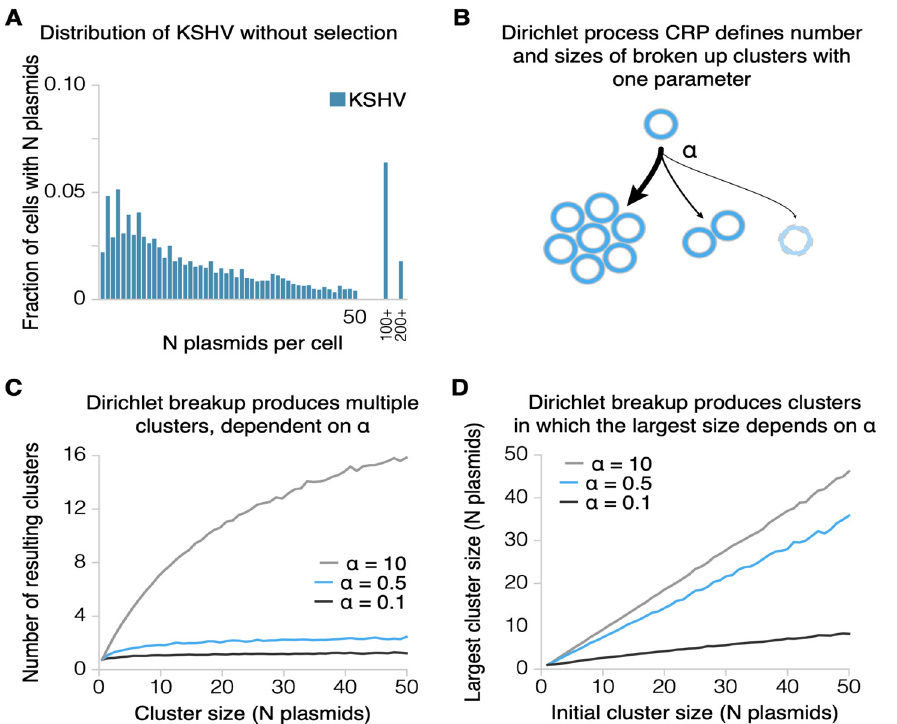
Figure 4. The distribution of KSHV plasmids per cell requires the addition of the modeling of clusters of plasmids and their associated breakup. ( A ) The distribution of KSHV plasmids per cell with no selection. Two bars at the right show the fraction of simulated cells with unrealistically high numbers of plasmids per cell. ( B ) The CRP is entered for each plasmid with a probability of 0.8 (as described in the findings of Chiu et al. [2]). This breaks up clusters, assigning each resulting cluster to the first resulting breakup cluster, and is passed then to successive clusters until a new cluster is formed. This process is represented here with the relative probabilities of forming each size of cluster. ( C ) The CRP produces multiple resulting clusters, the number of which is defined by the “ α ” parameter. The optimum value of “ α ” was identified to be 0.5 [2]. ( D ) Varying “ α ” also affects the resulting cluster sizes, the largest of which are represented here.